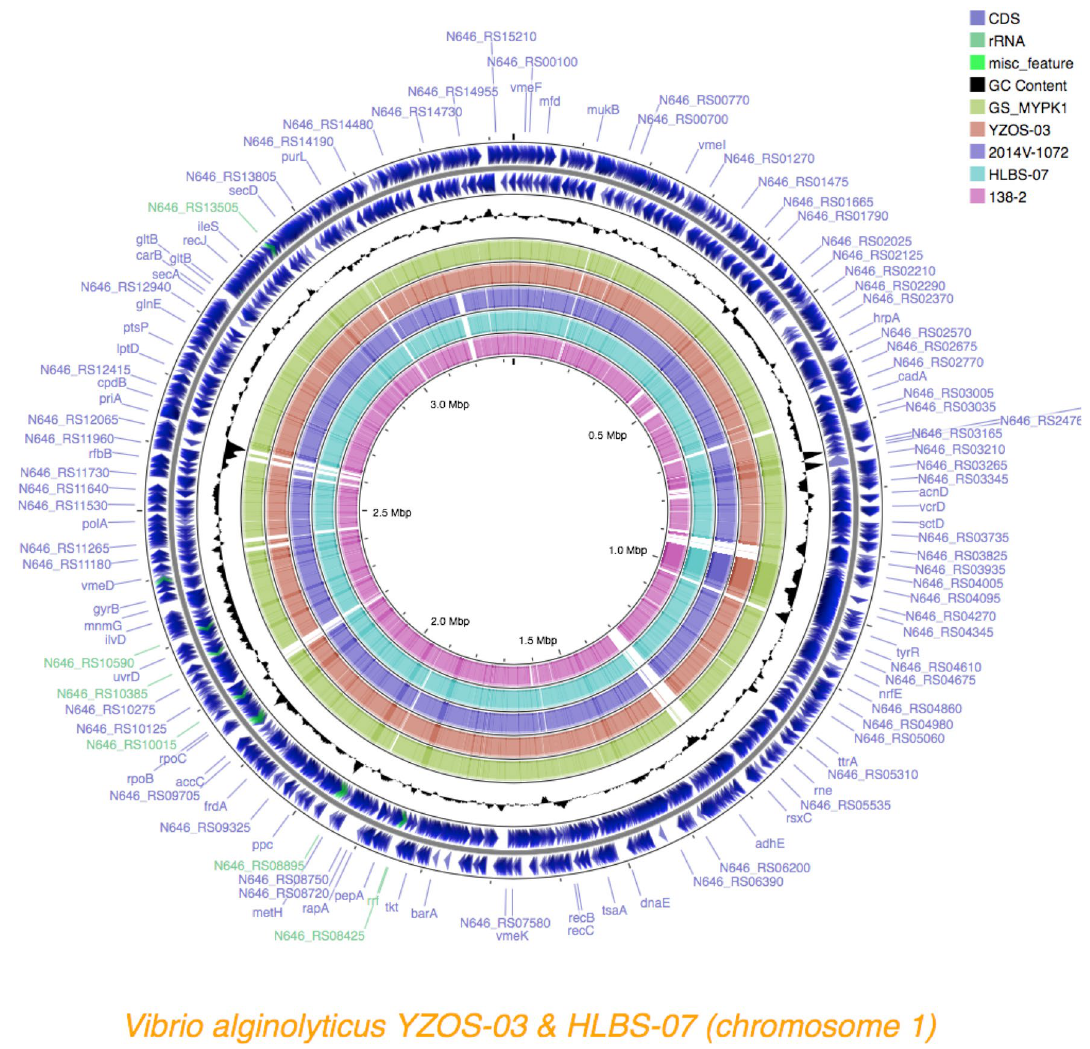
Figure 6. Structure of chromosome1 of Vibrio alginolyticus . Chromosomal sequences of V. alginolyticus G3_MYPK1, 2014V-1072,138-2 HLBS-07 and YZOS-03 strains were mapped based on NBRC15630. CDSs were estimated with Prokka analysis on the